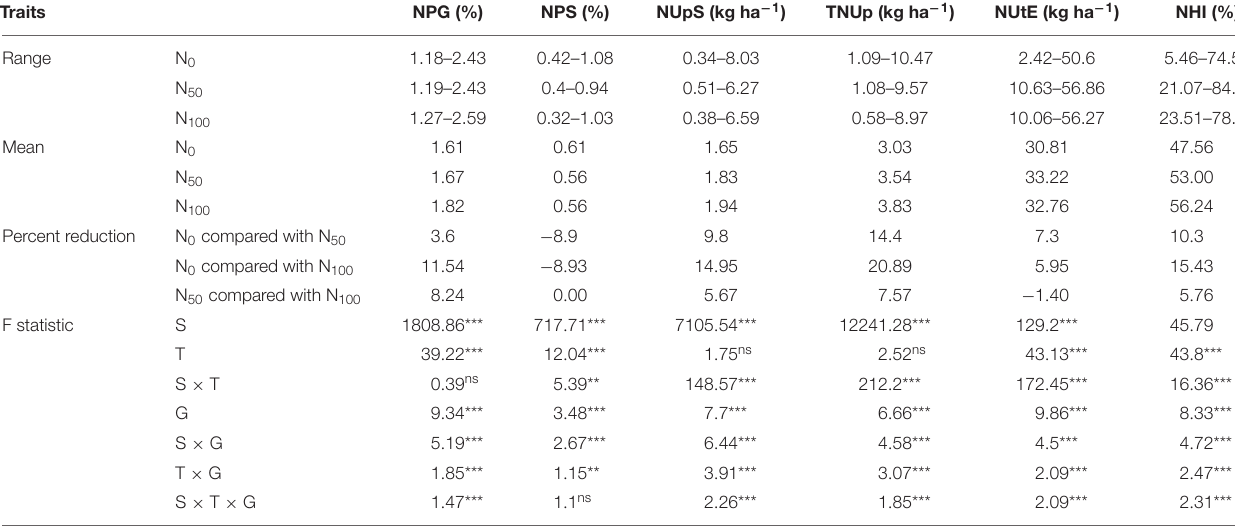
TABLE 3 | ANOVA for N-related traits under three nitrogen levels during Summer 2017 and 2018.